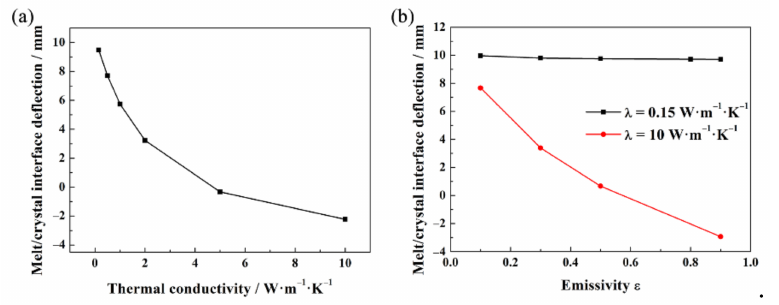
Figure 4. The curves of the melt/crystal interface deflection versus ( a ) thermal conductivity and ( b ) emissivity of the insulation